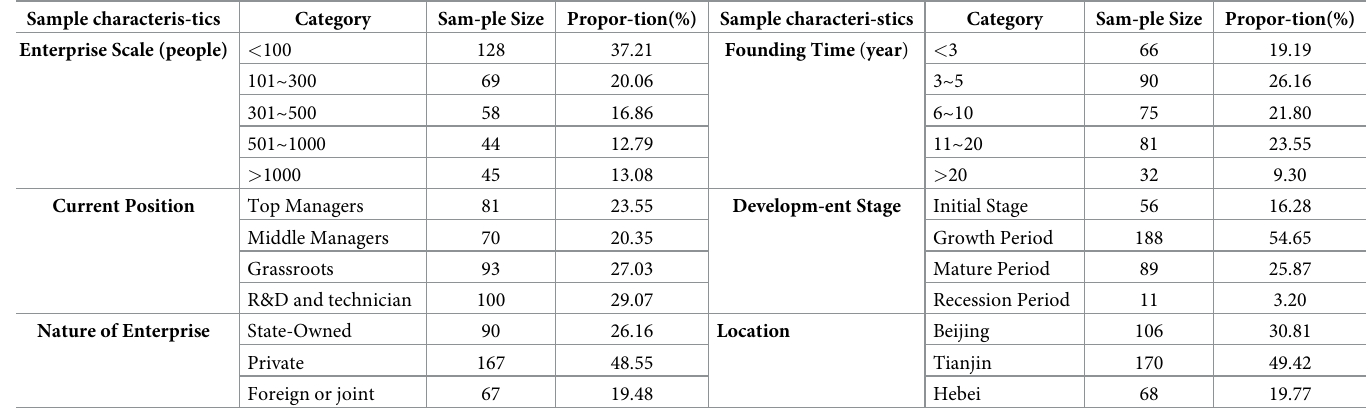
Table 1. Distribution characteristics of sample enterprises.